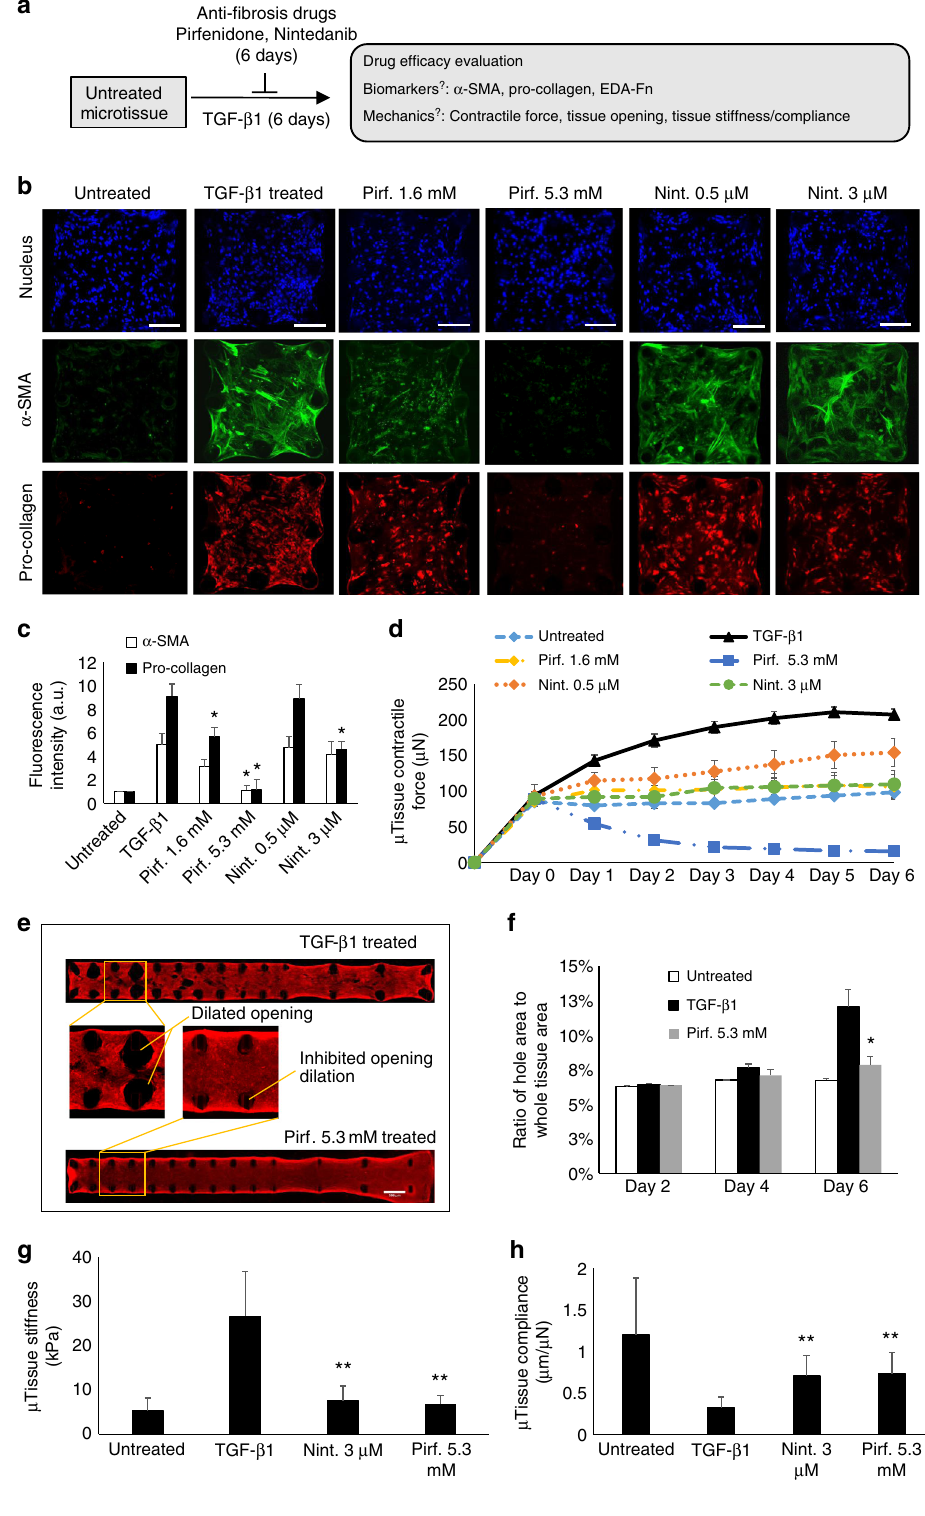
ef fi cacy of anti- fi brosis drugs in humans. Pirfenidone and Nin- tedanib were selected for proof-of-concept as they are the only anti- fi brosis drugs approved by FDA to treat IPF; both drugs were shown to reduce the decline in lung compliance in IPF patients 30,31 . We performed both preventative and therapeutic treatments on diseased microtissue model using these drugs